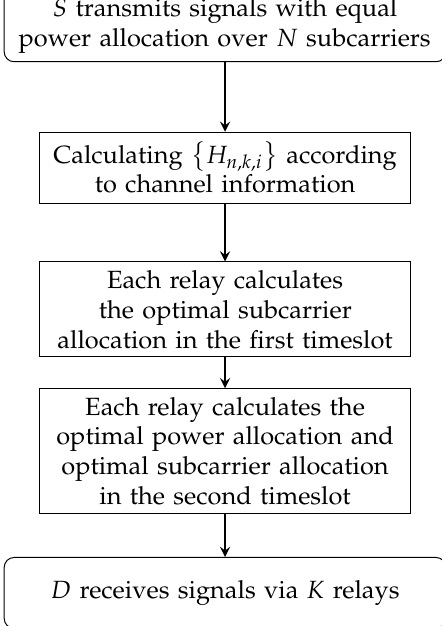
Figure 2. Flowchart of the proposed algorithm.